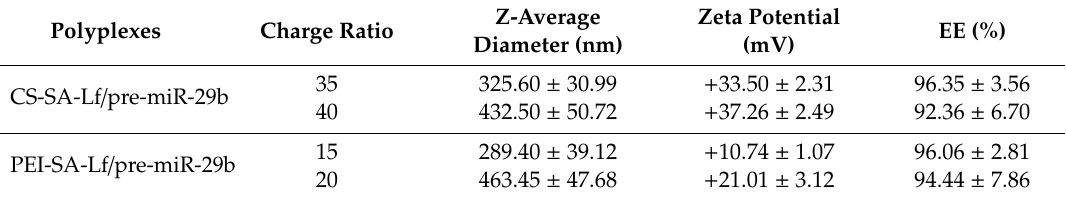
Characterization of chitosan–stearic acid–lactoferrin (CS-SA-Lf) / pre-miR-29b and polyethyleneimine–stearic acid–lactoferrin (PEI-SA-Lf) / pre-miR-29b